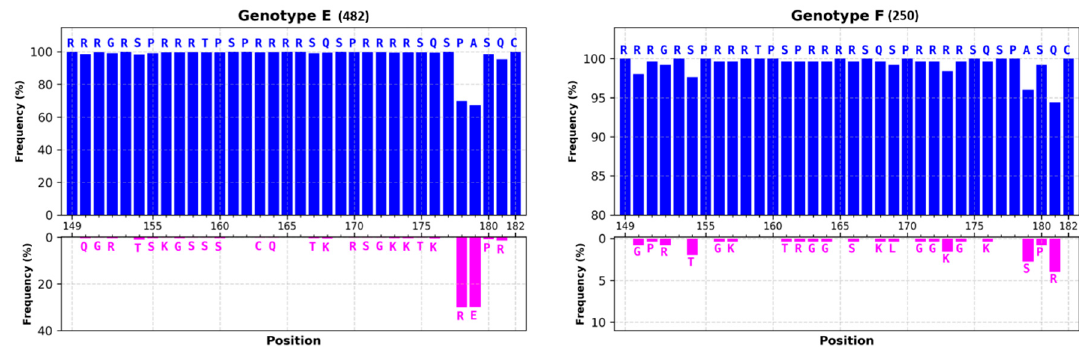
Figure 5. Conservation of the CTD amino acid sequences of the most prevalent genotypes. CTD sequences were extracted from the HBV database at Institut de Biologie Physico-Chimie (IBCP) IBCP (Lyon, France, https://hbvdb.ibcp.fr/HBVdb/). Numbers in parentheses correspond to numbers of analyzed sequences. Blue histograms correspond to overall conservation of residue at each position of the consensus sequence presented at the top of the graph. Pink histograms correspond to the most frequent substitution found in sequence alignment. Note that the genotype A CTD possesses two extra amino acids. Vertical axes represent frequencies of amino acid residues, expressed as percentage of conservation. In blue histograms, the axis was normalized between 80 to 100%, while in pink histograms, the axis was normalized between 0 to 10%, except for genotype E.